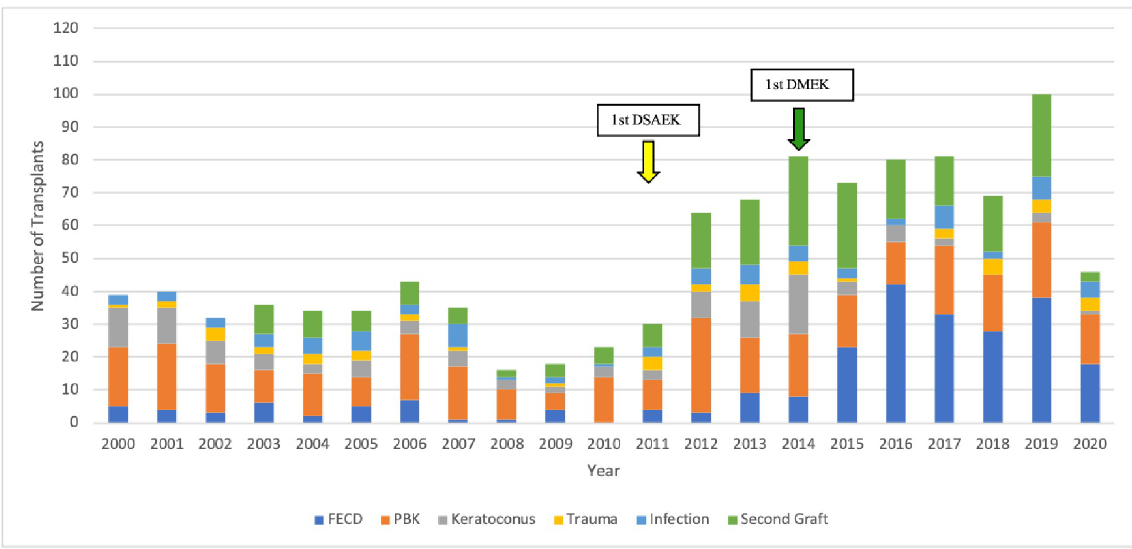
Fig 2. Changes over time in the indications for corneal grafting. DSAEK, Descemet stripping automated endothelial keratoplasty; DMEK, Descemet membrane endothelial keratoplasty; FECD, Fuchs endothelial cell dystrophy; PBK, pseudophakic bullous